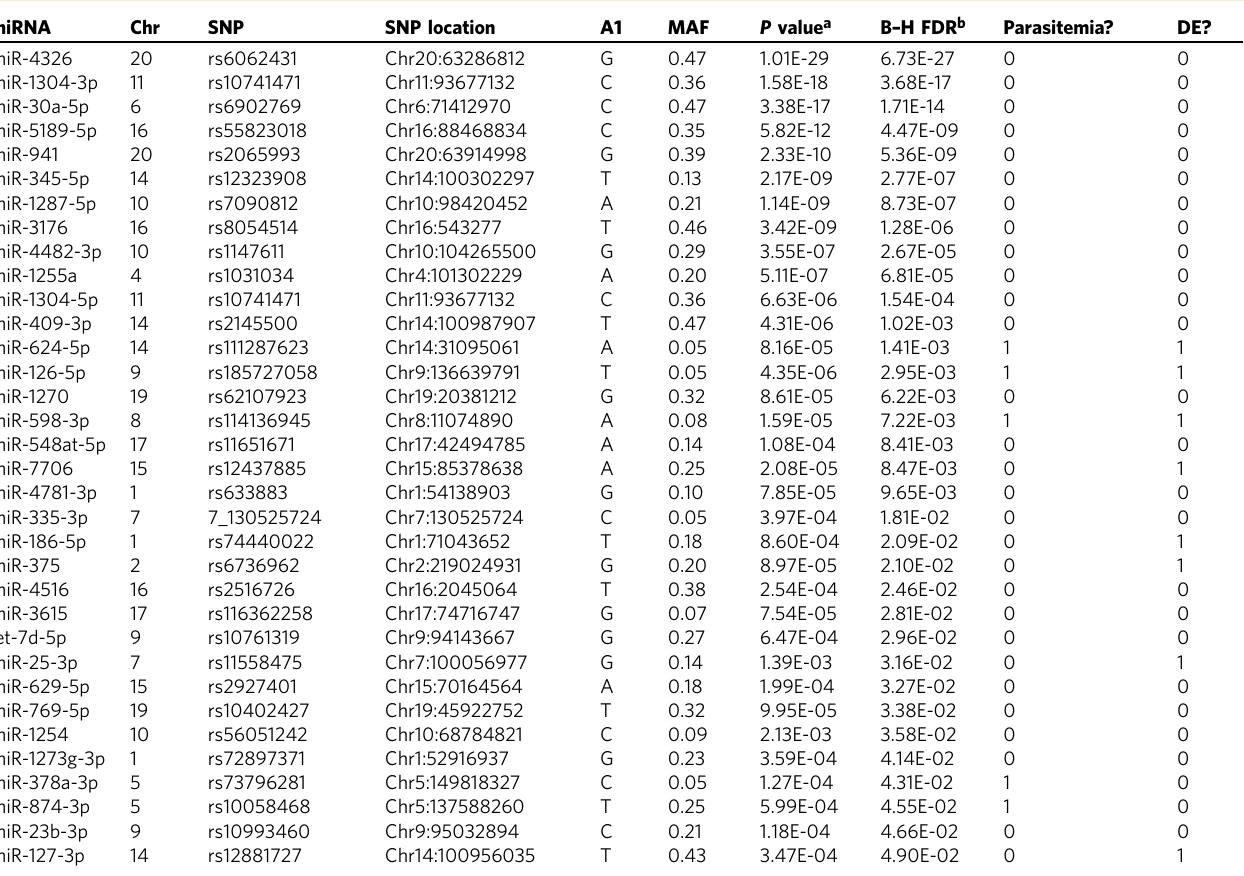
Table 1 Top 34 most signi fi cant miRNA-SNP associations (Linear regression, PLINK v1.9).